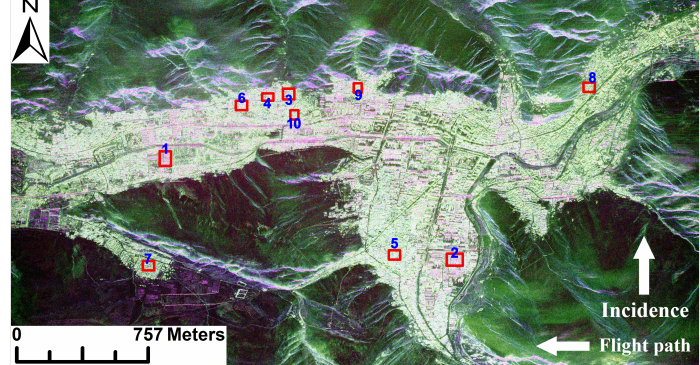
Figure 2. Map of the location of the Yushu earthquake.